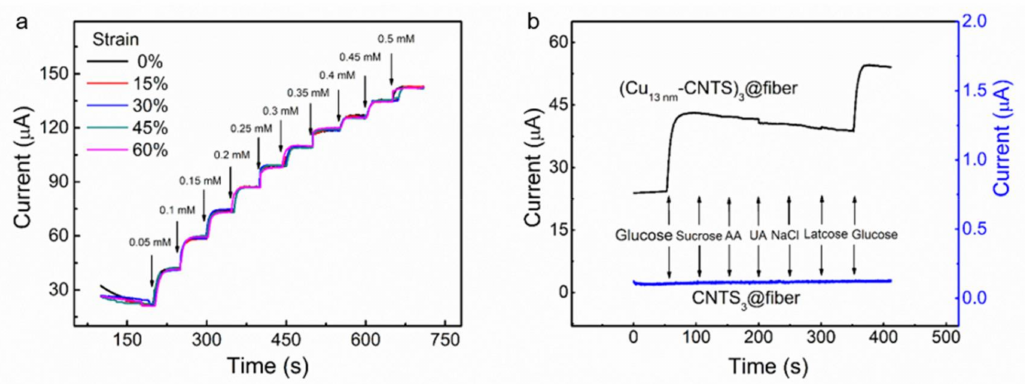
Figure 7. ( a ) Current as a function of time of the (Cu 13nm -CNTS) 3 @fiber electrode at different strain with dropwise addition of glucose in PBS solution at 50 s interval. By adding one drop of glucose, the glucose concentration increased by 0.05 mM in the detection solution, and the detection potential was +0.35 V. ( b ) Current as a function of time of the (Cu 13nm -CNTS) 3 @fiber electrode and CNTS 3 @fiber electrode with addition of glucose and interferents as indicated into PBS solution. By adding one drop of glucose, the glucose concentration increased by 0.05 mM in the detection solution, and by adding one drop of interferents, the corresponding concentration also increased as follows: sucrose (0.008 mM), AA (0.008 mM), UA (0.008 mM), NaCl solution (150 mM), and lactose (0.008 mM). The applied potential was +0.35